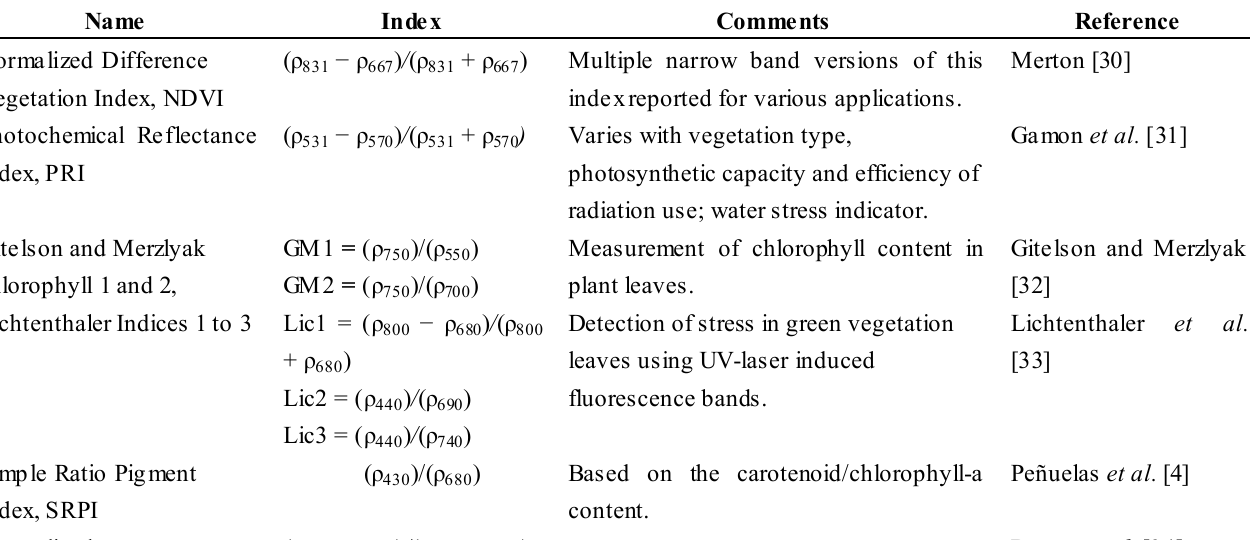
Table 2. Summary of the 7 spectral indices derived from the in situ hyperspectral measurements for this